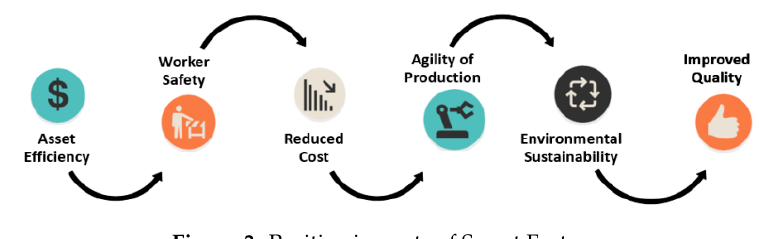
Figure 3. Positive impacts of Smart Factory.